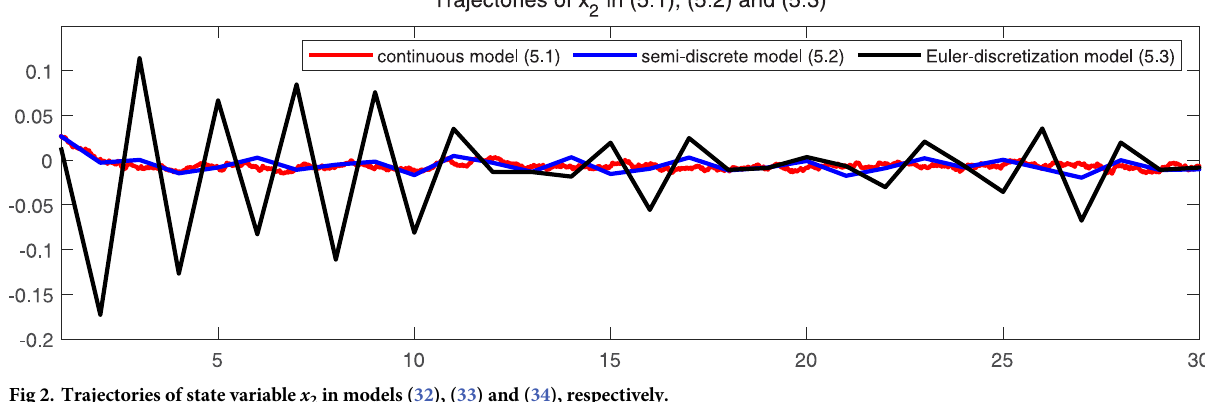
PLOS ONE | https://doi.org/10.1371/journal.pone.0220861 August 7,